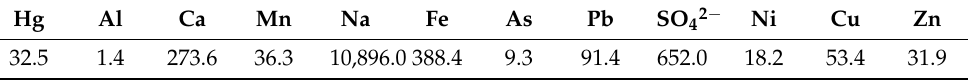
Table 1. Initial solute concentrations (mg/L) in the synthetic AMD-gold processing effluents. Hg Al Ca